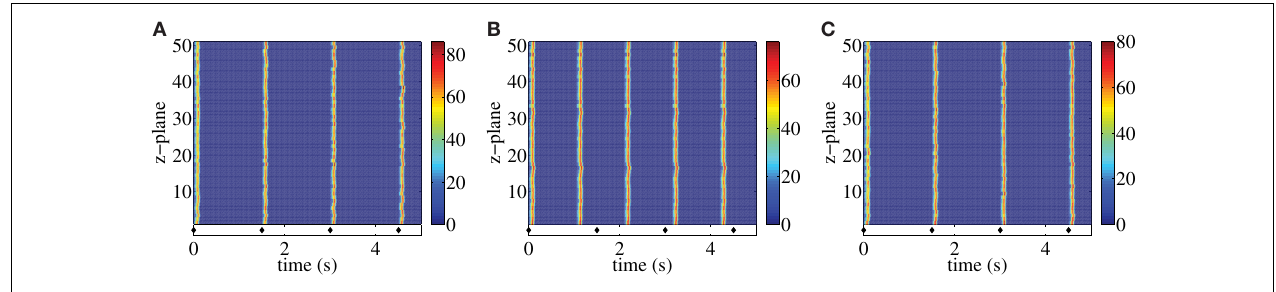
(C). Each stimulation is indicated by a diamond symbol.Warm colors indicate substantial Ca 2 + release site activity, while cool colors correspond to lesser Ca 2 + release activity. Other parameter values are as in Table 1 .